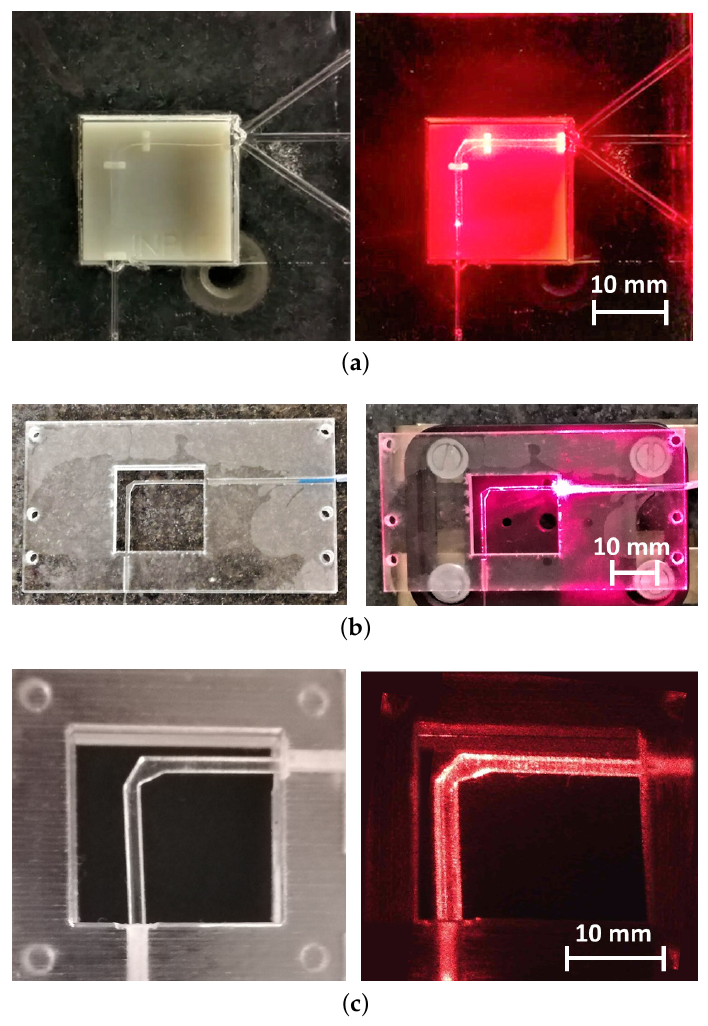
Figure 8. The pictures of the µ SPT in the no-light passage and during light-passage conditions. The top shows ( a ) the PDMS- µ SPT , the center shows ( b ) the PMMA- µ SPT , and the bottom shows ( c ) the VeroClear- µ SPT